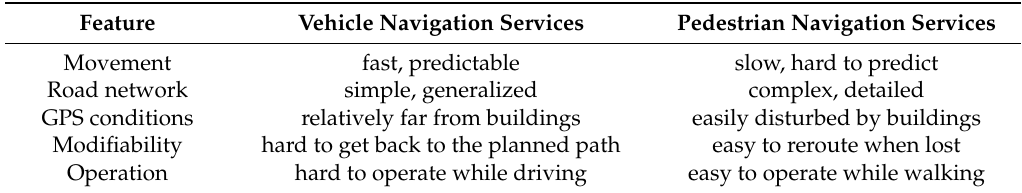
Figure 1. Examples of GPS signals and network datasets from ( a ) vehicle and ( b ) Pedestrian Navigation Services. Solid lines are the background network datasets, and points are the recorded GPS signals. Table 1. Differences between navigation services for vehicles and pedestrians.